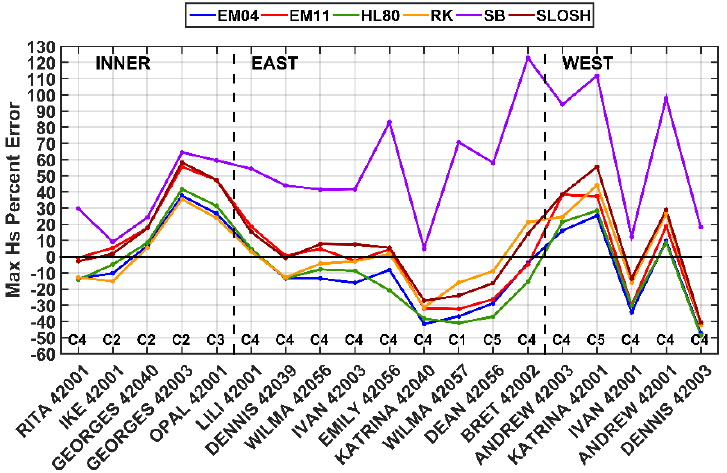
Figure 9. Maximum Hs error percentage between model results and measurements for all TC.